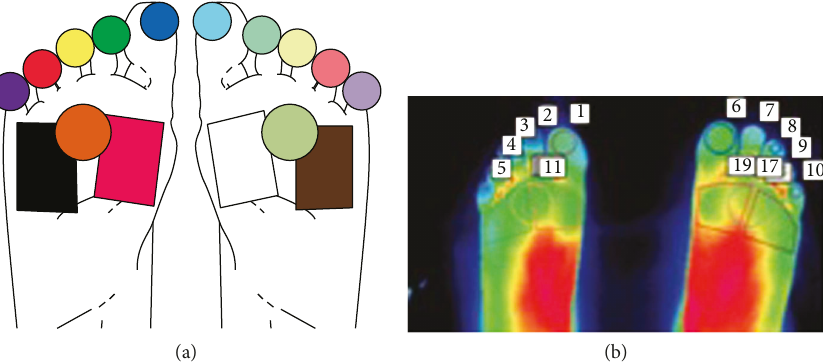
Figure 1: (a) Diagram showing the foot regions considered for temperature extraction. (b) An actual thermal image and the corresponding regions of interest. The temperatures from the toe regions and forefoot regions were considered for further analysis.